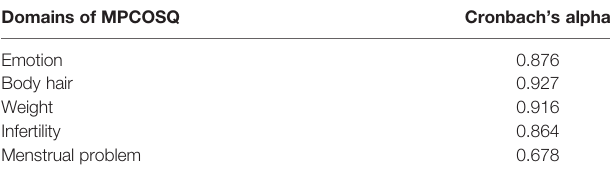
TABLE 2 | Reliability test of